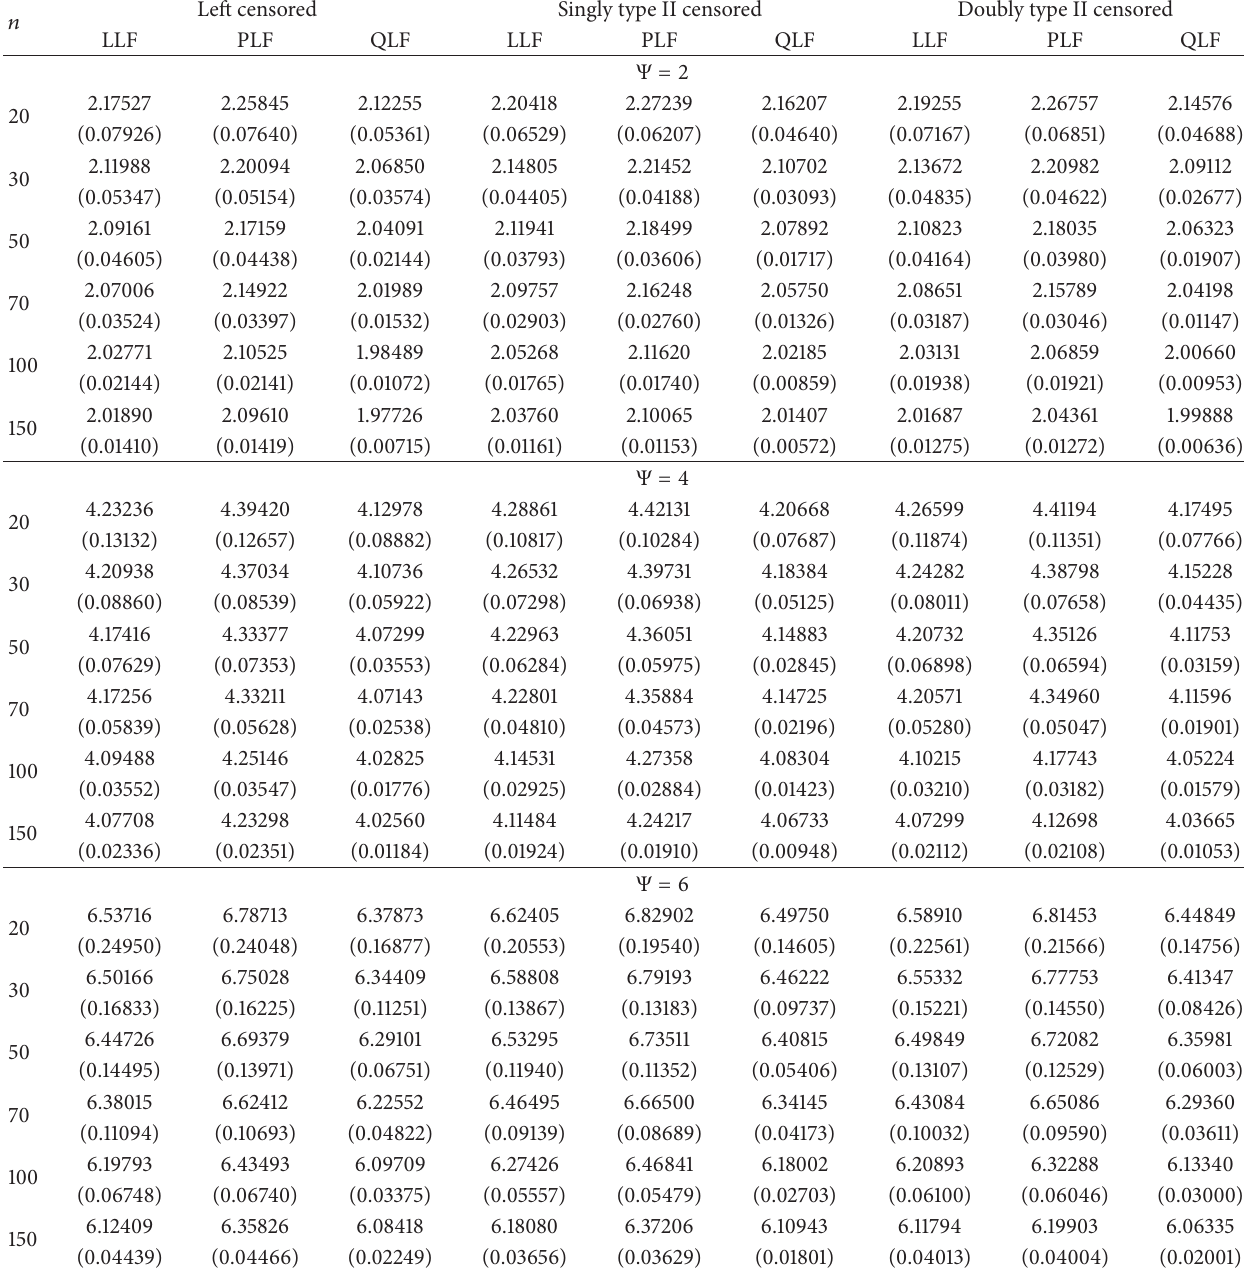
Table 4: Bayes estimators and posterior risks under gamma